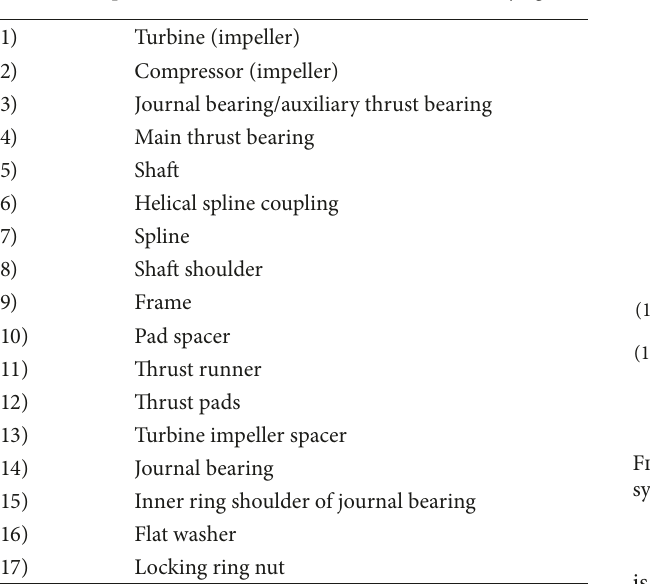
Table 2: Components and details numbered in the assembly figures.